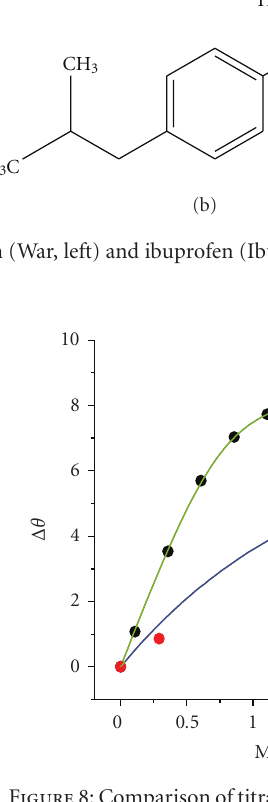
Figure 7: Titrations of HSA in the presence of 1.75 mol equivalents of Cu(II) with War (A) and Ibu (B) from 0 to 2.5 mol equivalents in 0.25 mol equivalent steps. The titration of War was terminated at 2mol equivalents due to the loss of solution transparency. The solid lines represent linear fits to the data.